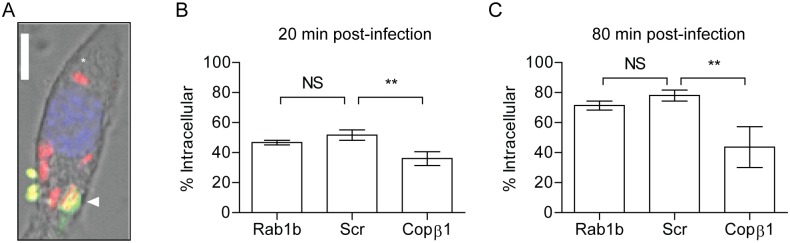
Rab1b knockdown does not impact Y. pestis invasion of macrophages.RAW264.7 macrophages were reverse transfected with Rab1b, scrambled (Scr), or Copβ1 siRNA. 48 h after transfection cells were infected with Y. pestis CO92 pCD1(-)pGEN-P
EM7::DsRED (MOI 7.5). 20 or 80 min post-infection cells and bacteria were fixed with paraformaldehyde and extracellular bacteria were stained by indirect immunofluorescence with anti-Y. pestis antibody. (A) Representative image showing differential staining of intracellular (red) and extracellular (green or yellow) bacteria. Scale bar is 5μm. Asterisk denotes intracellular Y. pestis. (B and C) Percentage of intracellular bacteria calculated at 20 and 80 min post-infection, respectively. ** = p<0.01, ns = not significant.